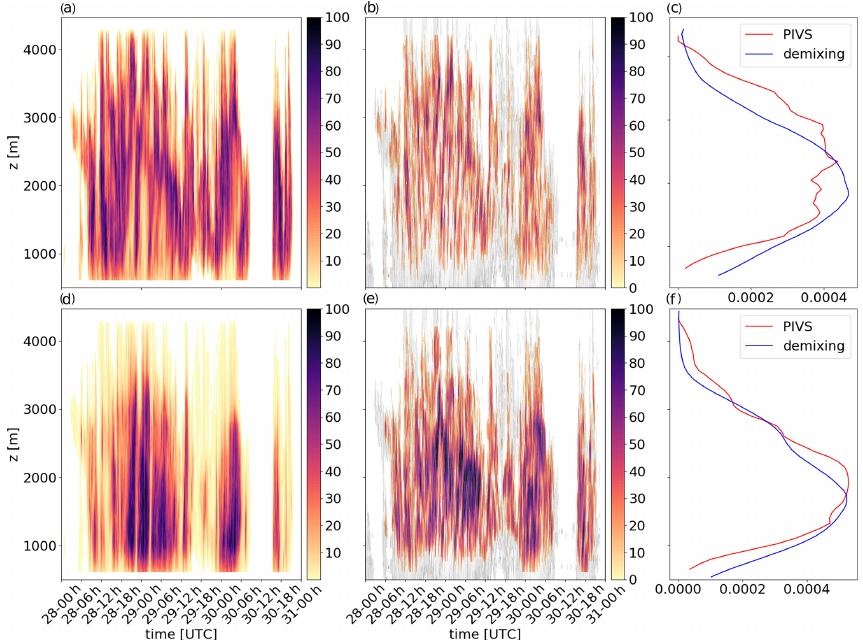
Figure 5. Panel (a) (respectively, d ) shows the time–height plot for EV1 of the proportion of crystals CR (respectively, aggregates AG and rimed particles RP) from the demixing algorithm. Panel (b) (respectively, e ) shows the time–height plot of the proportion of CG (respectively, AR) from the PIVS method. Panel (c) (respectively, f ) shows the vertical plots of the occurrence density of the CR demixed proportion and CG proportion during the event. The proportion for demixing is the number of counts for a specific hydrometeor divided by the total number of counts in this pixel and weighted by the proportion of profiles with significant signal at that height (i.e., with any process identified by PIVS) among all profiles. This enables a meaningful quantitative comparison between the two methods.